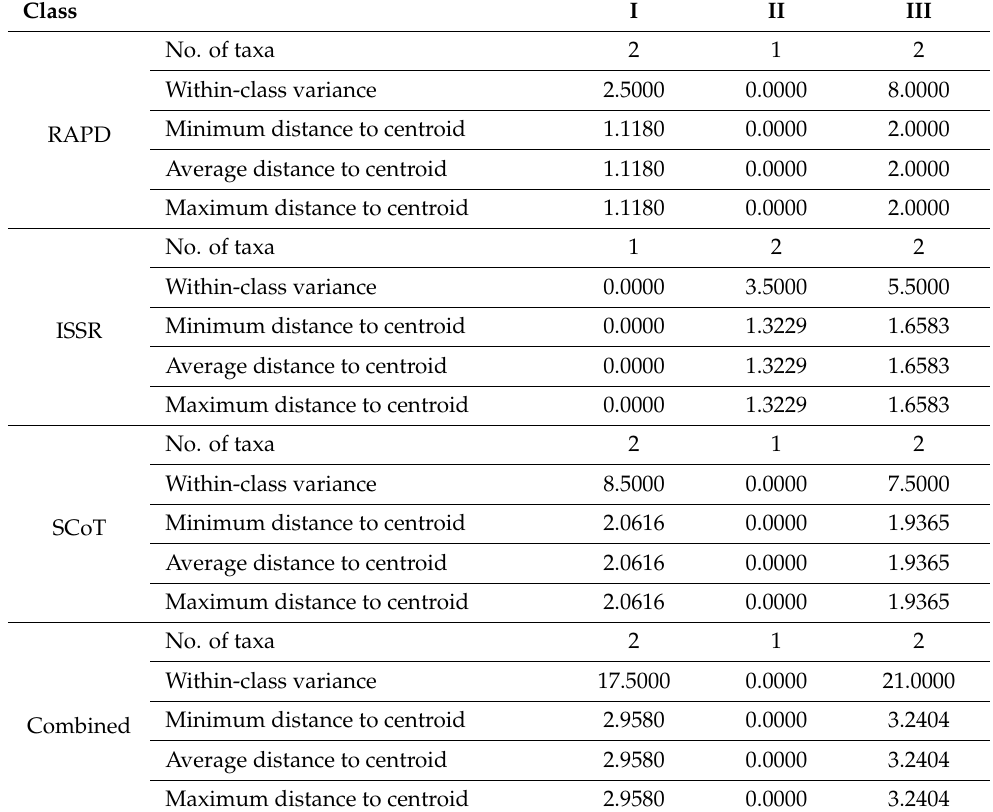
Table 5. Distances to centroids between the classes of taxa.